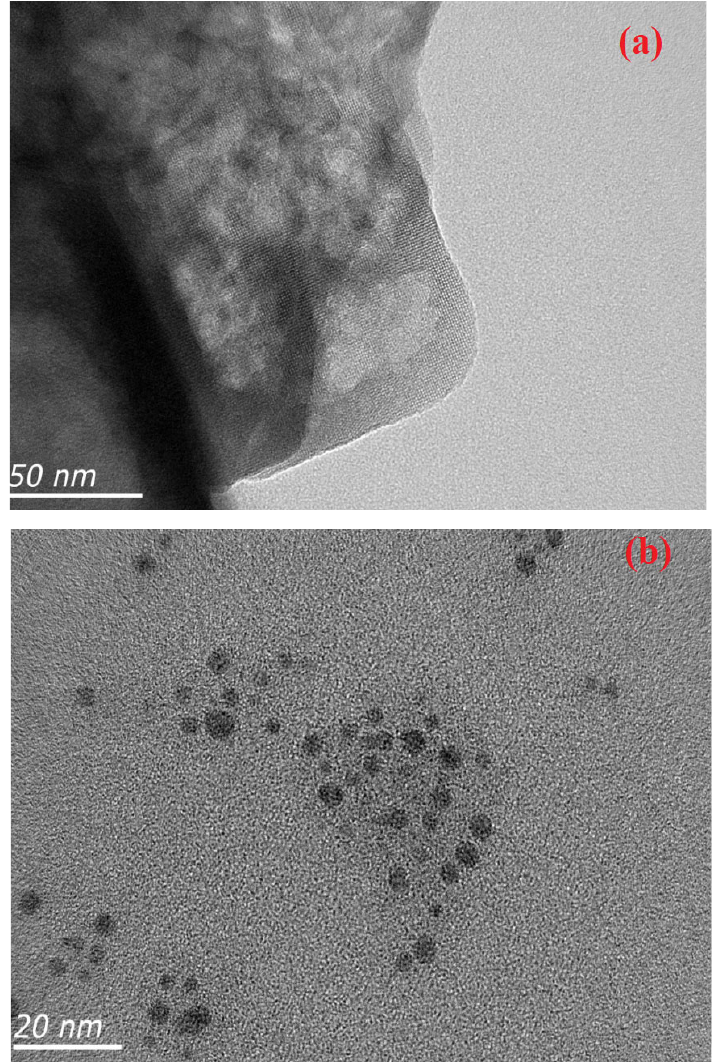
Figure 4. Pore size distribution (BJH) of parent and hierarchical zeolite samples . TEM analysis revealed the typical platelet-like morphology of the hierarchical zeo- lite (Figure 5). The TEM images show some morphological changes in the zeolite surface morphology. TEM analysis reflects the BET data that confirm mesopore formation. The black spots on the hierarchical zeolite surface may indicate the deposition of nickel par- ticles, as shown in Figure 5b.